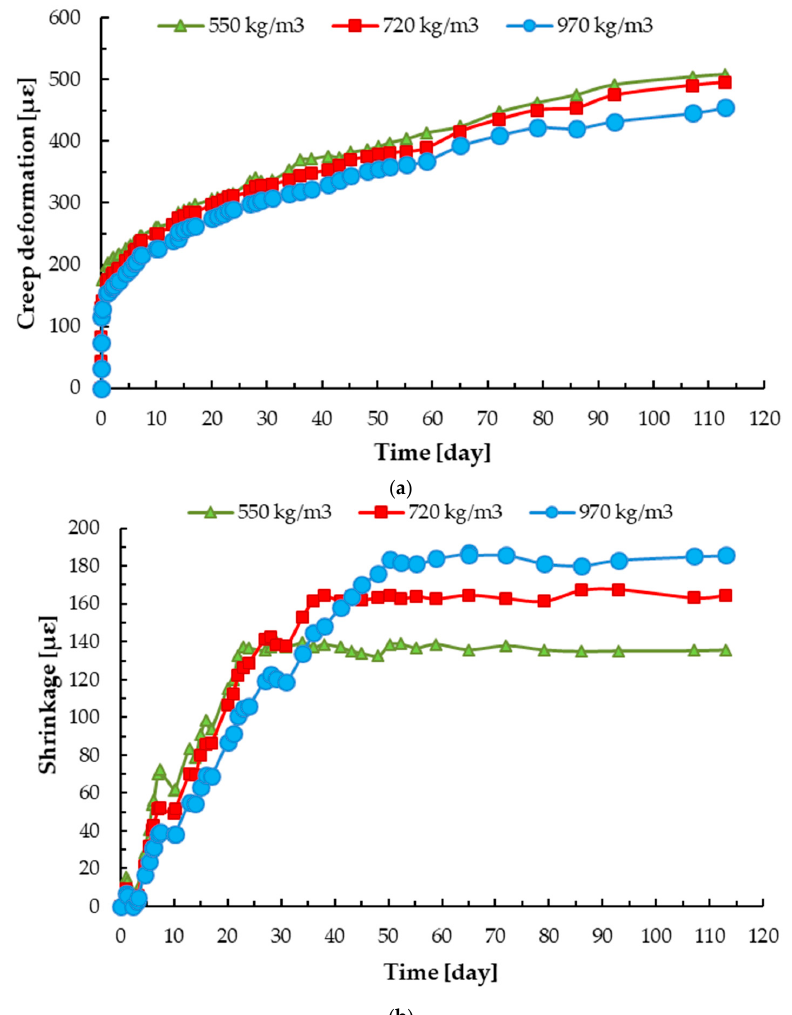
Figure 9. Relationship between creep deformation ( a ) and shrinkage ( b ) and time for foamed concrete with different densities.